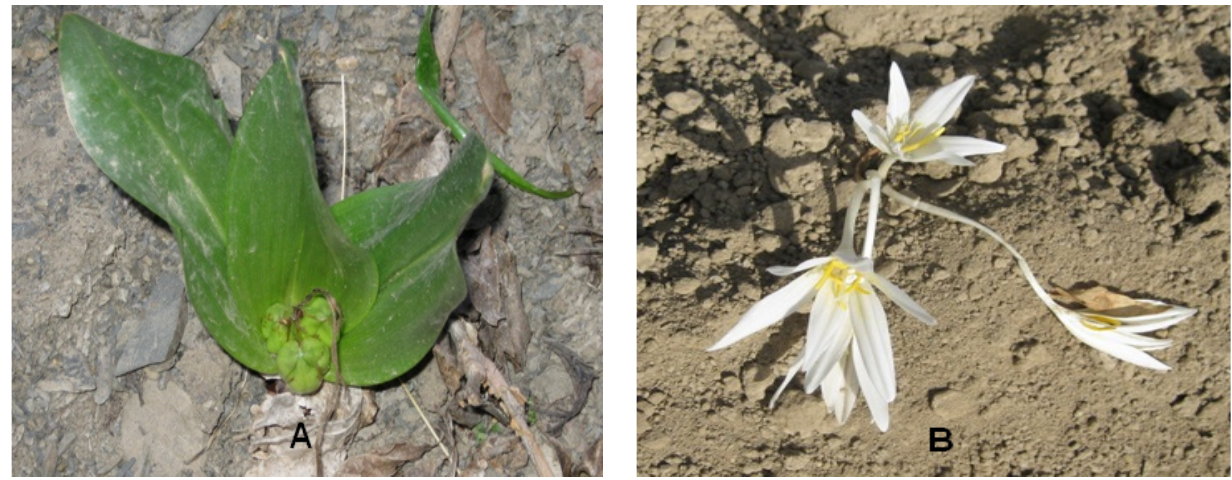
Fig.1. Colchicum kotschyi Boiss, vegetative growth (A) and flowering stage